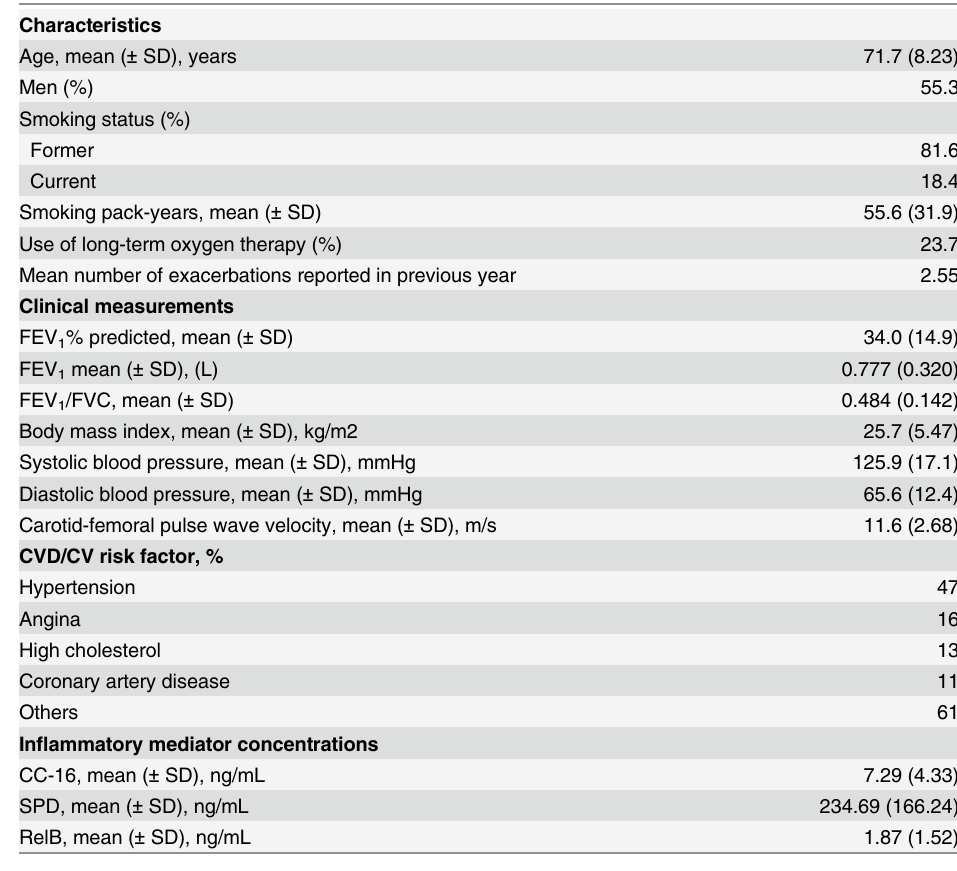
Table 1. Characteristics and clinical measurements at initial assessment during exacerbation in sub- jects with COPD (n = 38).